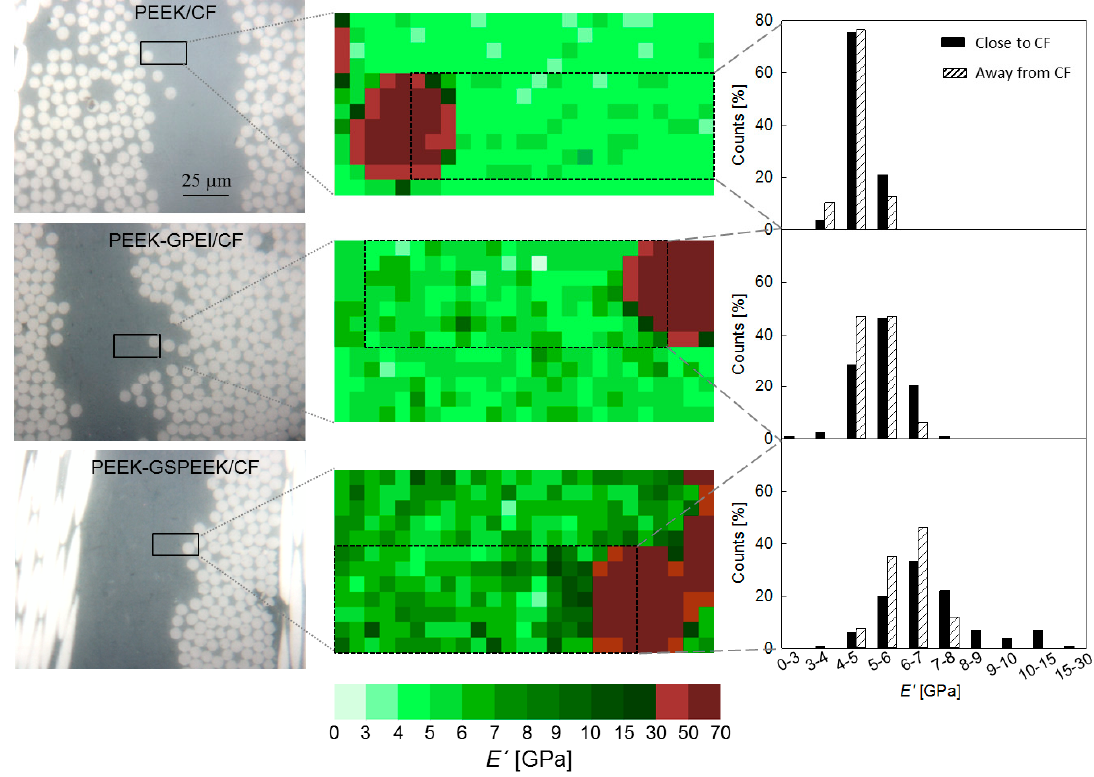
Figure 6. ( Left ) Microscopy images of the three laminates showing an overview of the regions selected for nanoindentation mapping (marked by rectangles). ( Middle ) Mechanical maps constructed by representing the E’ values at h = 100 nm for each location (the colour code appears at the bottom). Grids of 25 × 12 indents separated by 1 µ m were used. The black rectangles denote the portion of data selected for the counting analysis close to the CF. ( Right ) Bar chart illustrating the counting analysis carried out close to (solid bars) and far away from (dashed bars) the fibres front.